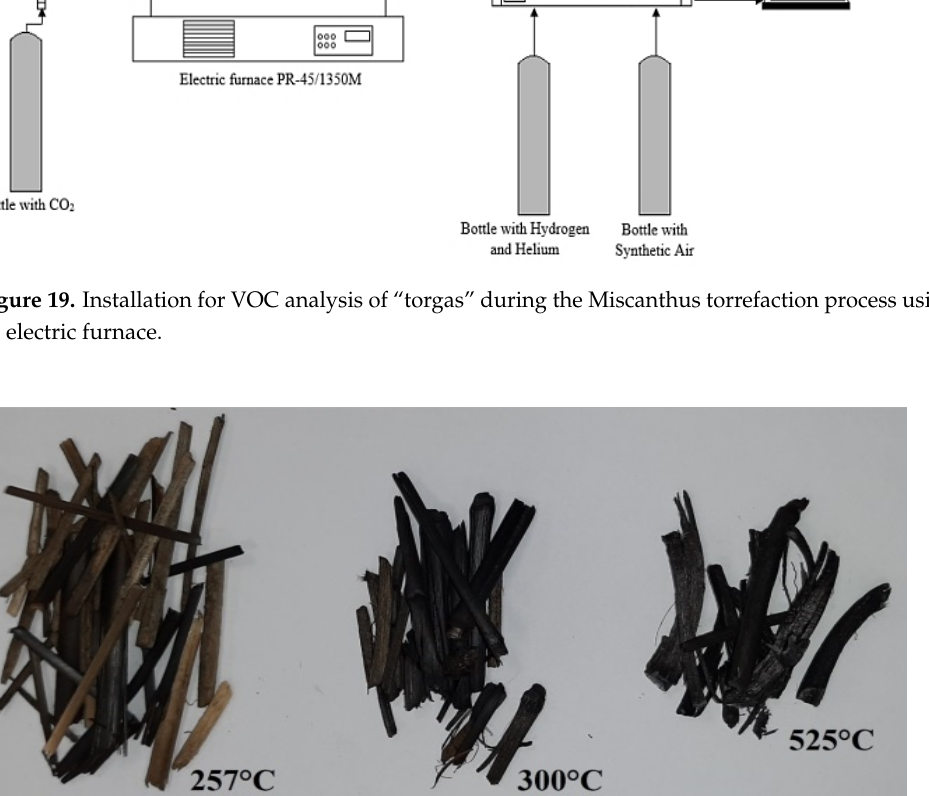
Figure 20. Torrefied Miscanthus samples after process at selected temperatures.